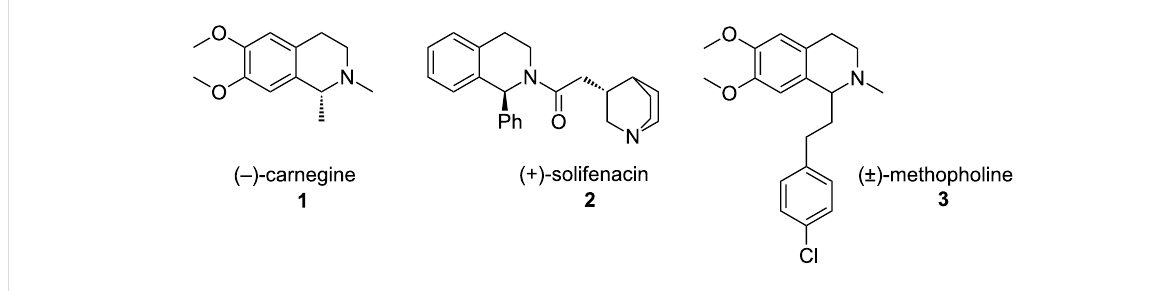
Figure 1: Examples of biologically active 1,2-disubstituted tetrahydroisoquinolines.